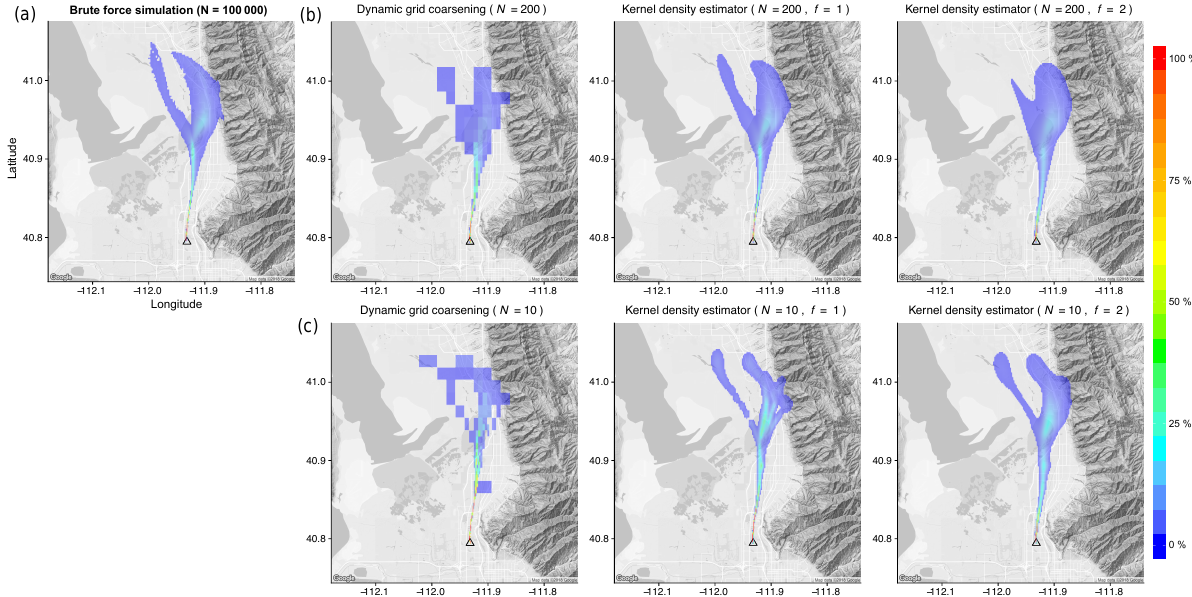
Figure 4. Comparison of footprint calculation methods. Simulating a large number of particles ( N = 10 5 ) and gridding by location (a) gives a physically constrained expectation for the footprint. Using subsets of 200 particles (b) and 10 particles (c) , the kernel density estimator demonstrates considerable improvements over the traditional dynamic grid coarsening. Modifying the kernel bandwidths ( f = 2) can improve results in uncommon cases, such as the 10-particle